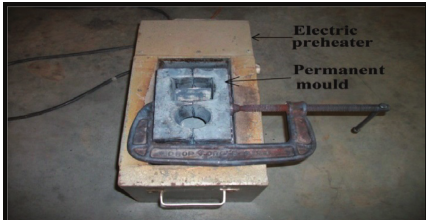
Figure 2: Preheater of the permanent